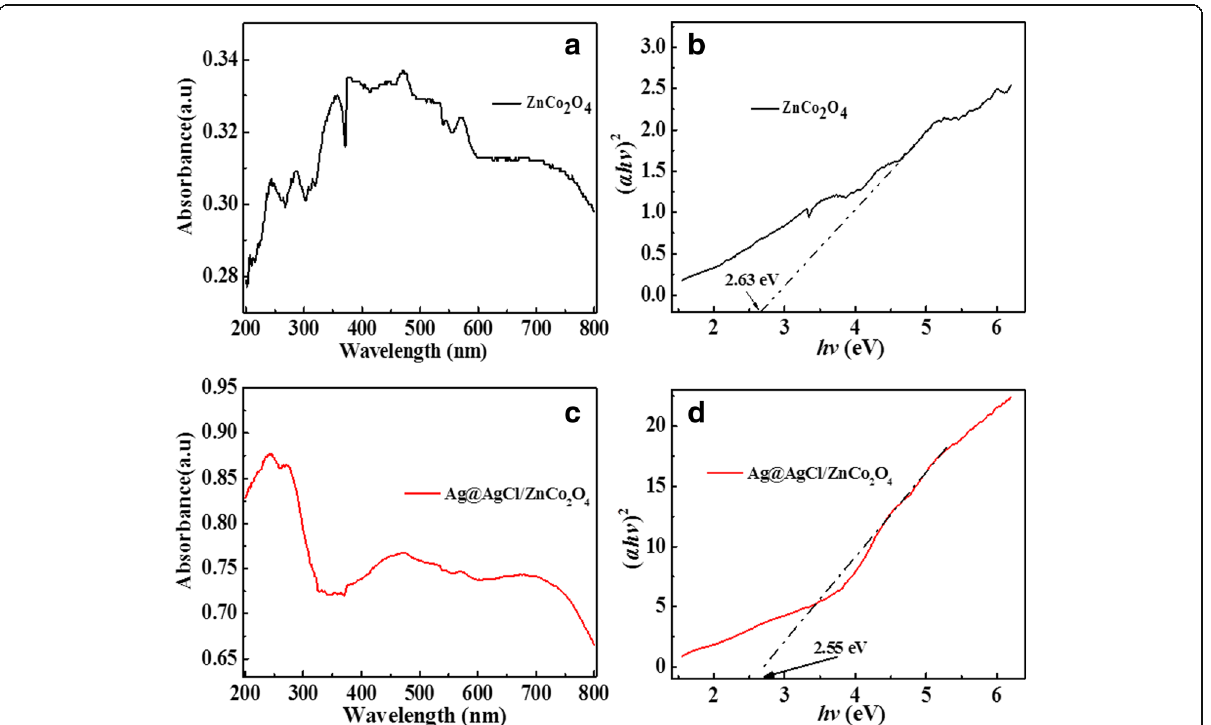
Fig. 4 a UV-Vis diffuse reflectance spectra of ZnCo 2 O 4 . b Plots of ( α hv ) 2 versus energy ( hv ) for the band gap energy of ZnCo 2 O 4 . c UV-Vis diffuse reflectance spectra of 0.2Ag@AgCl/ZnCo